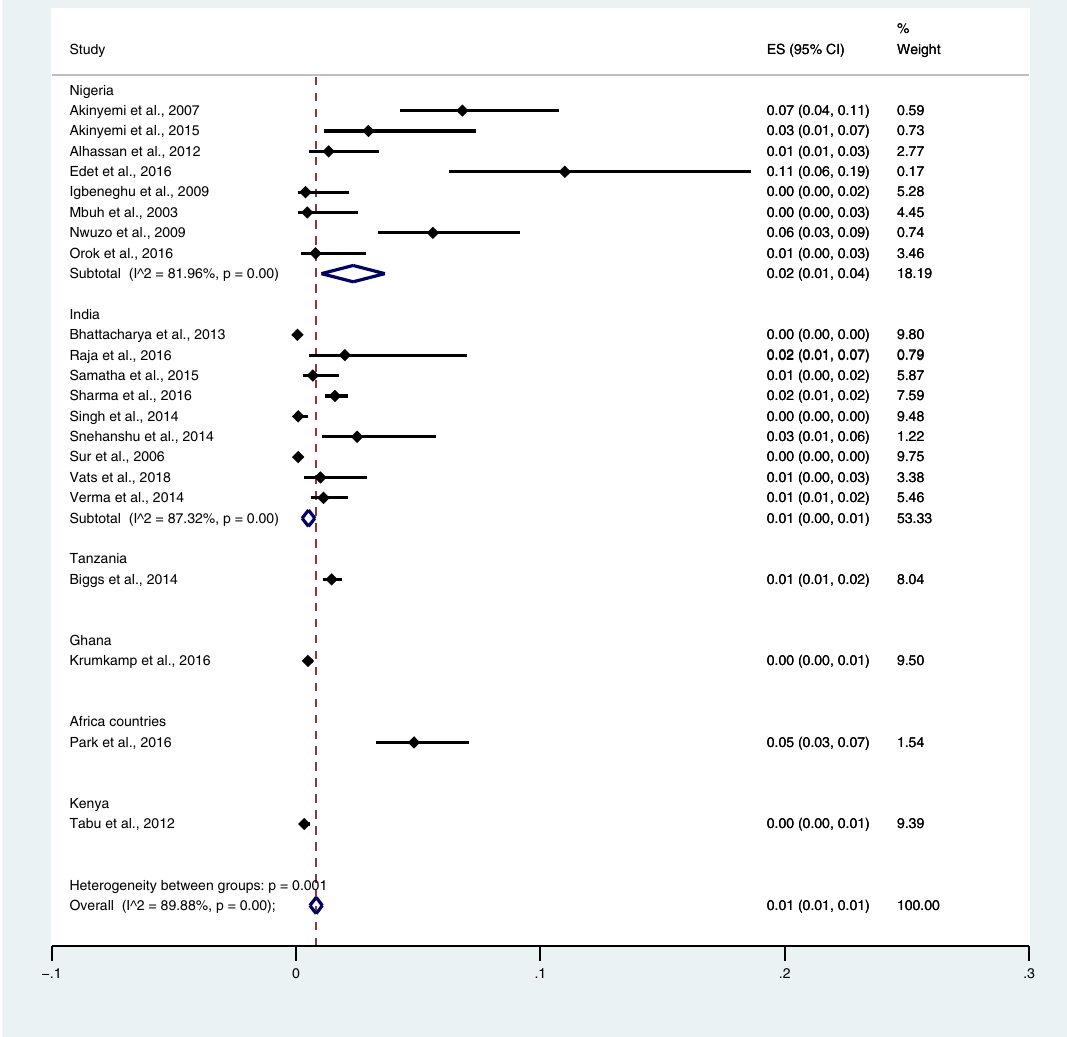
Figure 4. Pooled prevalence of typhoidal/NTS and malaria co-infection using blood cultures for the identification of Salmonella spp. infection stratified by countries. ES proportion estimate (multiply 100 units for interpreted as prevalence estimate), CI confidence interval, NS not